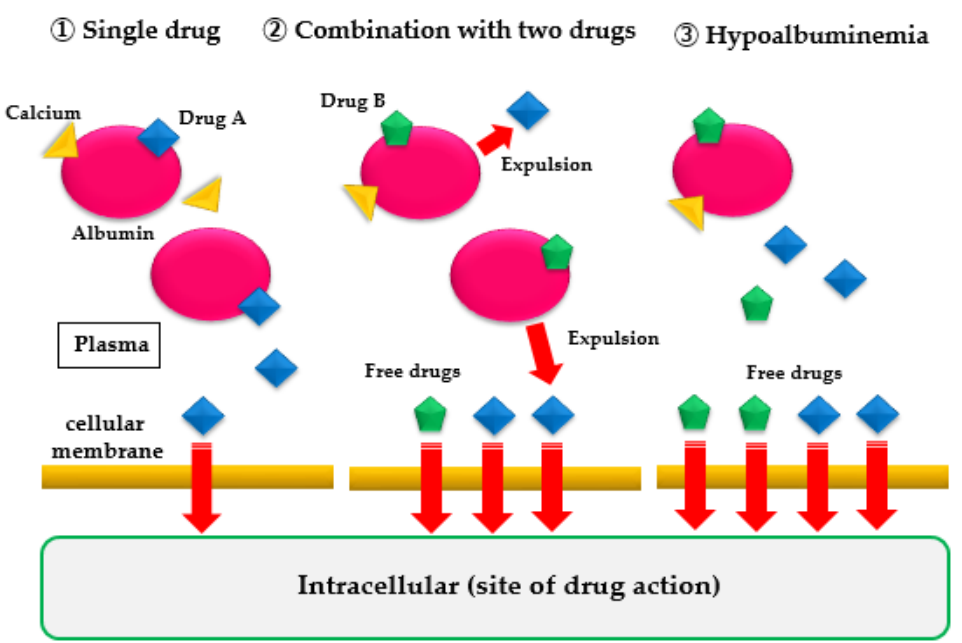
Figure 1. When a single drug is used alone or in combination with two drugs, or in case of hypoalbuminemia, the amount of free drug that does not bind to plasma albumin increases. Consequently, the amount of drug that passes through the cell membrane increases, and the drug effect is strongly expressed.